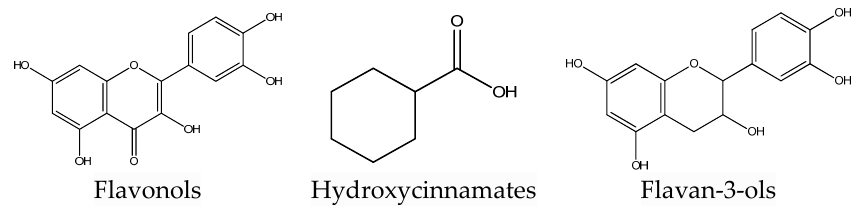
Figure 1. Some polyphenol compounds in peach fruit.